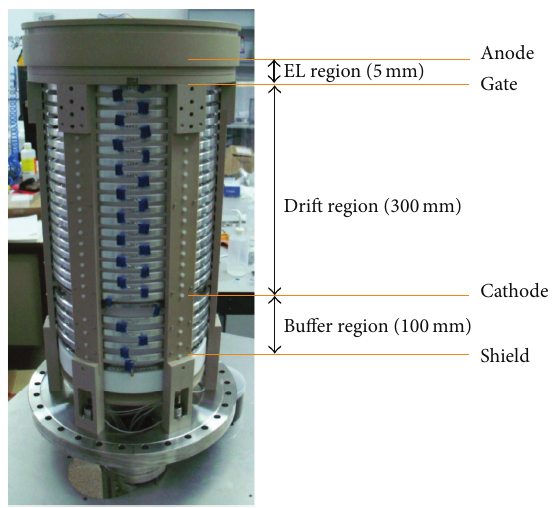
Figure 22: External view of the time projection chamber mounted on one endcap. The approximate positions of the different regions of the TPC are indicated.